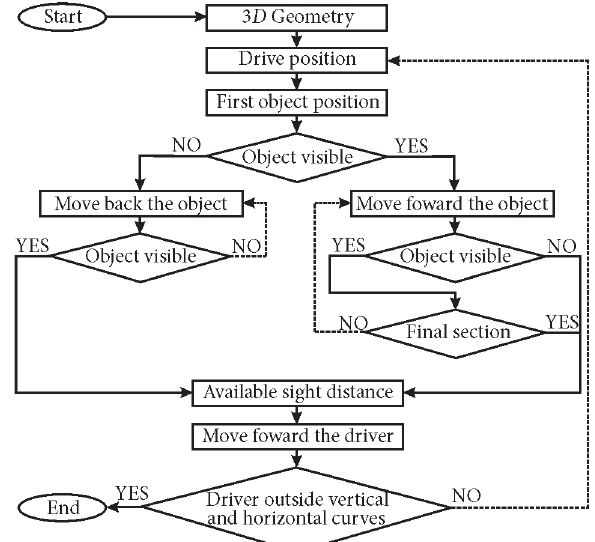
Fig. 2. Methodology to calculate available sight distance